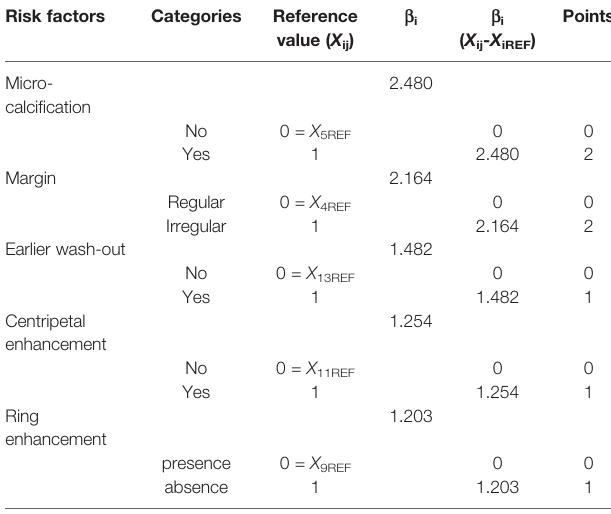
TABLE 5 | Development of weighted points for risk factors in the derivation cohort.